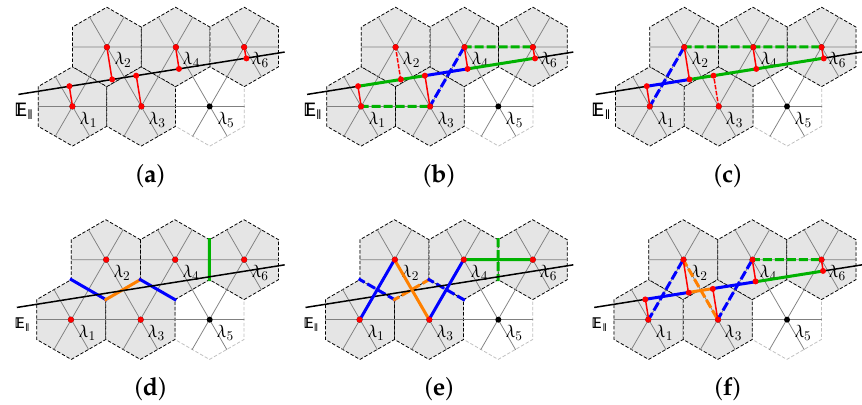
Figure 2. A cut and projection A 2 → E 1 , where E (cid:107) has a shallow enough slope that overlapping edges can arise when one is deciding which edges to select as tiles. ( a ) The space E (cid:107) intersects the Voronoi cells of lattices points λ i for i = { 1,2,3,4,6 } . It is not clear, however, which edges should be